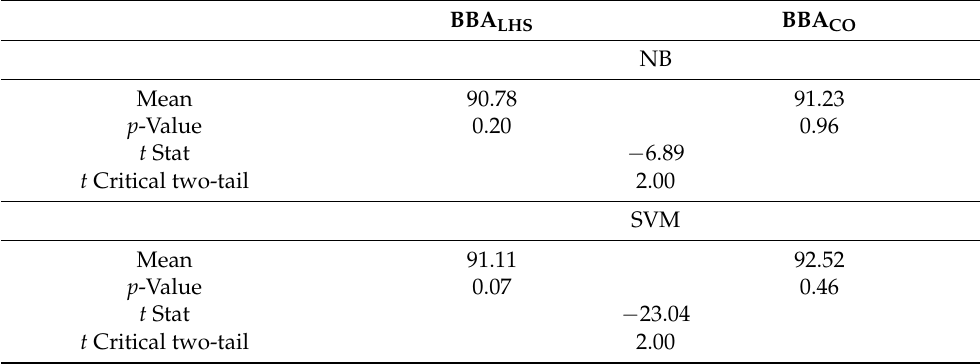
Table 24. The t -test of classification results of BBA LHS vs. BBA CO